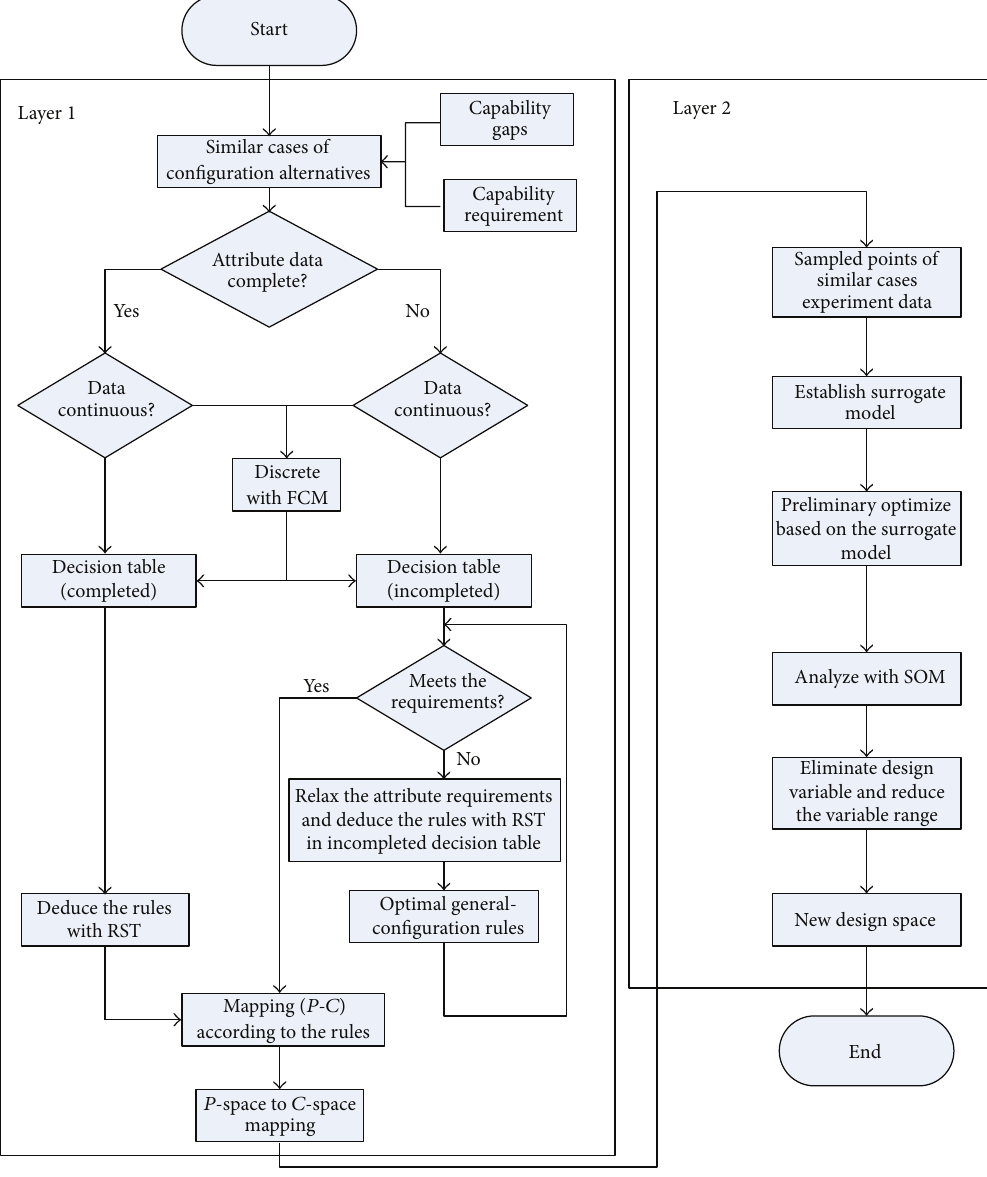
Figure 2: The Bilayer exploration